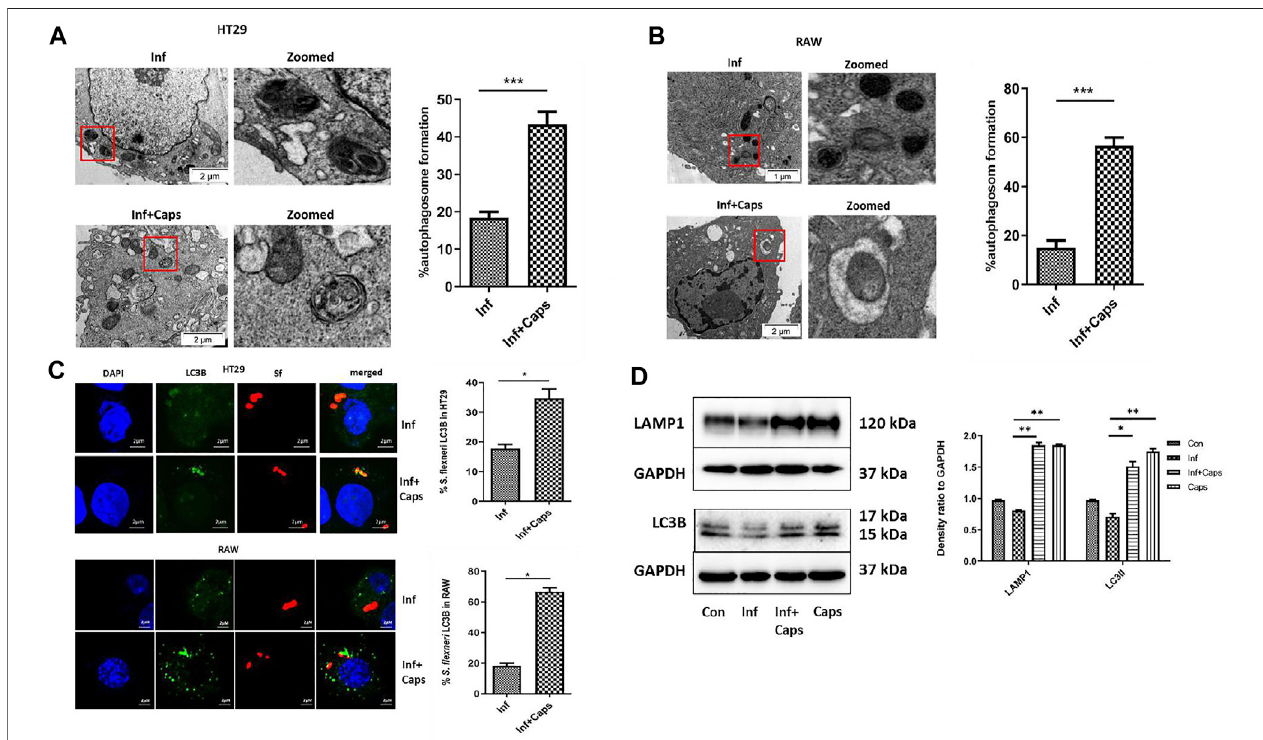
FIGURE4| Capstreatmentresultsintheengulfmentofbacteriabyautophagosome. (A) Transmissionelectronmicroscopy(TEM)picturesshowedthepresenceof autophagosomeformationininfected intestinalcellswithand withoutCapstreatment.Zoomed imagesofthemarkedarea.Scalebar:2 μ m.Graphicalrepresentationof %autophagosomeformationasobservedinTEM.Unpaired t -testwasperformed. (B) Transmissionelectronmicroscopy(TEM)picturesofautophagosomeformationin infected and infected + Caps RAW267.4 cells. Zoomed images of the marked area. Scale bar: 2 μ m. (C) Microscopic images of GFP-LC3B transfected intestinal cells (HT-29) showed the recruitment of S. fl exneri (red) to LC3B (green). Brie fl y, cells were transfected with GFP-LC3B plasmid, then treated with Caps for 2 h followed by S. fl exneri infection for 2 h. Graph representing the percentage of bacteria localizing with LC3B. Microscopy images of GFP-LC3B transfected macrophages (RAW 267.4) infected with bacteria and treated with and without Caps. Graph representing the number of bacteria recruited to LC3B. Unpaired t -test was performed. Scale bar: 2 μ M. (D) HT29 cells were pre-treated with Caps for 2 h followed by infection. After infection, cells were lysed. Cell lysates were subjected to